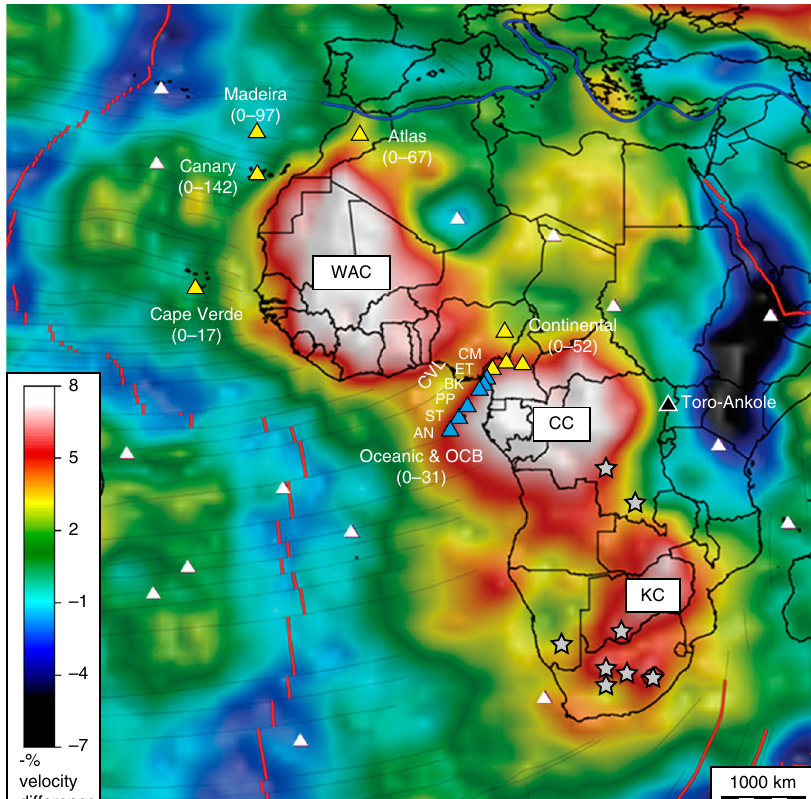
Fig. 1 Location of West African passive margin intraplate basalts. Light blue triangles show the oceanic and ocean – continental boundary (OCB) Cameroon volcanic line (CVL) volcanoes, which are the focus of this study: AN Annobòn, ST São Tomé, PP Principe, BK Bioko, ET Etínde, CM Mt. Cameroon. Yellow triangles represent the volcanoes whose isotopic compositions were compiled in this study. Numbers shown in a bracket are the eruption ages for each volcanic fi eld in millions of years 7 – 12 . The age for the Madeira and the Canary islands includes the data for neighbouring seamounts. The black triangle indicates the Toro-Ankole region where the pyroxenite xenolith in the subcontinental lithospheric mantle was obtained. White triangles indicate other volcanoes. WAC West African Craton, CC Congo Craton, KC Kalahari Craton. The grey star represents the location of Group 1 kimberlite that was used for the estimation of the refertilized SCLM compositions. Tomographic model image (Vs models, reference velocity is 4.5 km/s) at depths of 100 – 175 km for the African continent and Atlantic Ocean is after ref. 17 (reprinted from Lithos, vol. 112, Ultradeep continental roots and their oceanic remnants: A solution to the geochemical “ mantle reservoir ” problem?, O ’ Reilly et al. p. 1047, with permission from